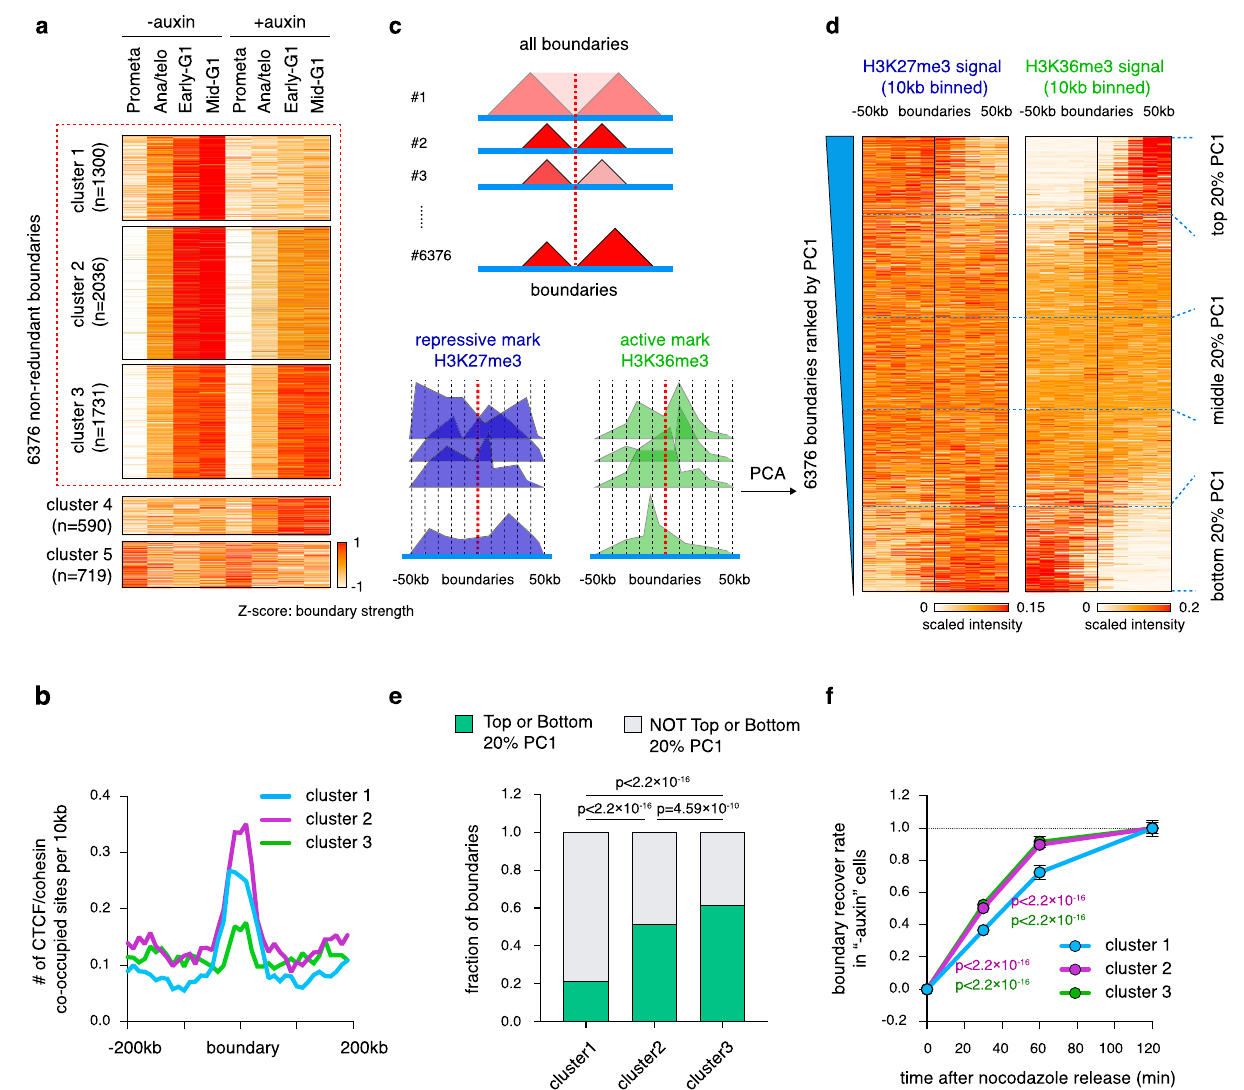
Fig. 2 Reformation of boundaries displays distinct responses to CTCF loss. a k -means clustering of boundaries depending on their sensitivity to CTCF depletion. The z-scores in prometaphase for cluster1 boundaries should not be interpreted as the absolute insulation intensity, because they are calculated as relative values across all time points (see the absolute insulation intensity in Supplementary Fig. 4f – h). b Average occupancy of CTCF/cohesin peaks per 10 kb for boundaries from cluster1 – 3. c Schematic of the principal component analysis (PCA)-based method using the H3k36me3 and H3K27me3 histone marks to assess boundaries as de fi ned here as chromatin state transitions. d ChIP-seq signal intensities of H3K27me3 and H3K36me3 in a 100 kb window centered on boundaries. Boundaries were ranked by their PC1 projections in descending order. The top and bottom regions (20%) of the heatmap indicate the transition of chromatin state from 5 ′ inactive to 3 ′ active and 5 ′ active to 3 ′ inactive, respectively. e Bar graphs showing the fraction of boundaries from each cluster with top or bottom 20% PC1 values. P values were computed by two-sided Fisher ’ s exact test. n = 282, 1050, 1068 for cluster1, 2, and 3 boundaries with top or bottom 20% PC1 respectively. n = 1018, 986, 663 for cluster1, 2, and 3 boundaries not with top or bottom 20% PC1, respectively. f Line graph showing the kinetics of boundary formation of cluster1 – 3 in untreated cells. Error bars denote 95% con fi dence interval. Purple and green colored P values are calculated from comparisons between cluster1 ( n = 1300) and cluster2 ( n = 2036) or cluster3 ( n = 1731) boundaries, respectively. Two-sided Wilcoxon signed-rank